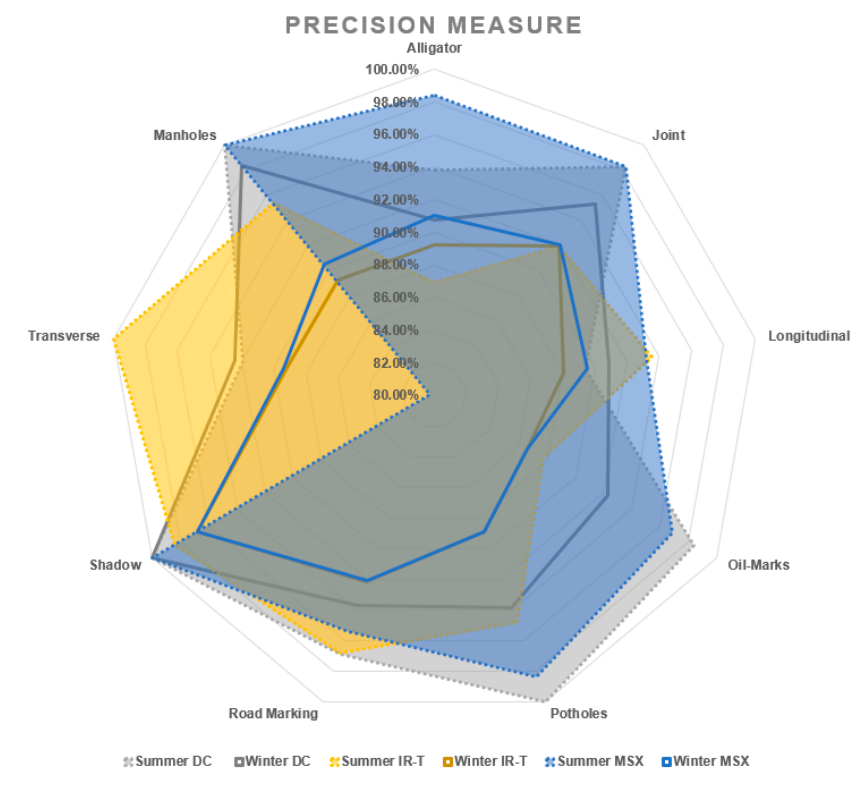
Figure 18. Sensitivity measure.